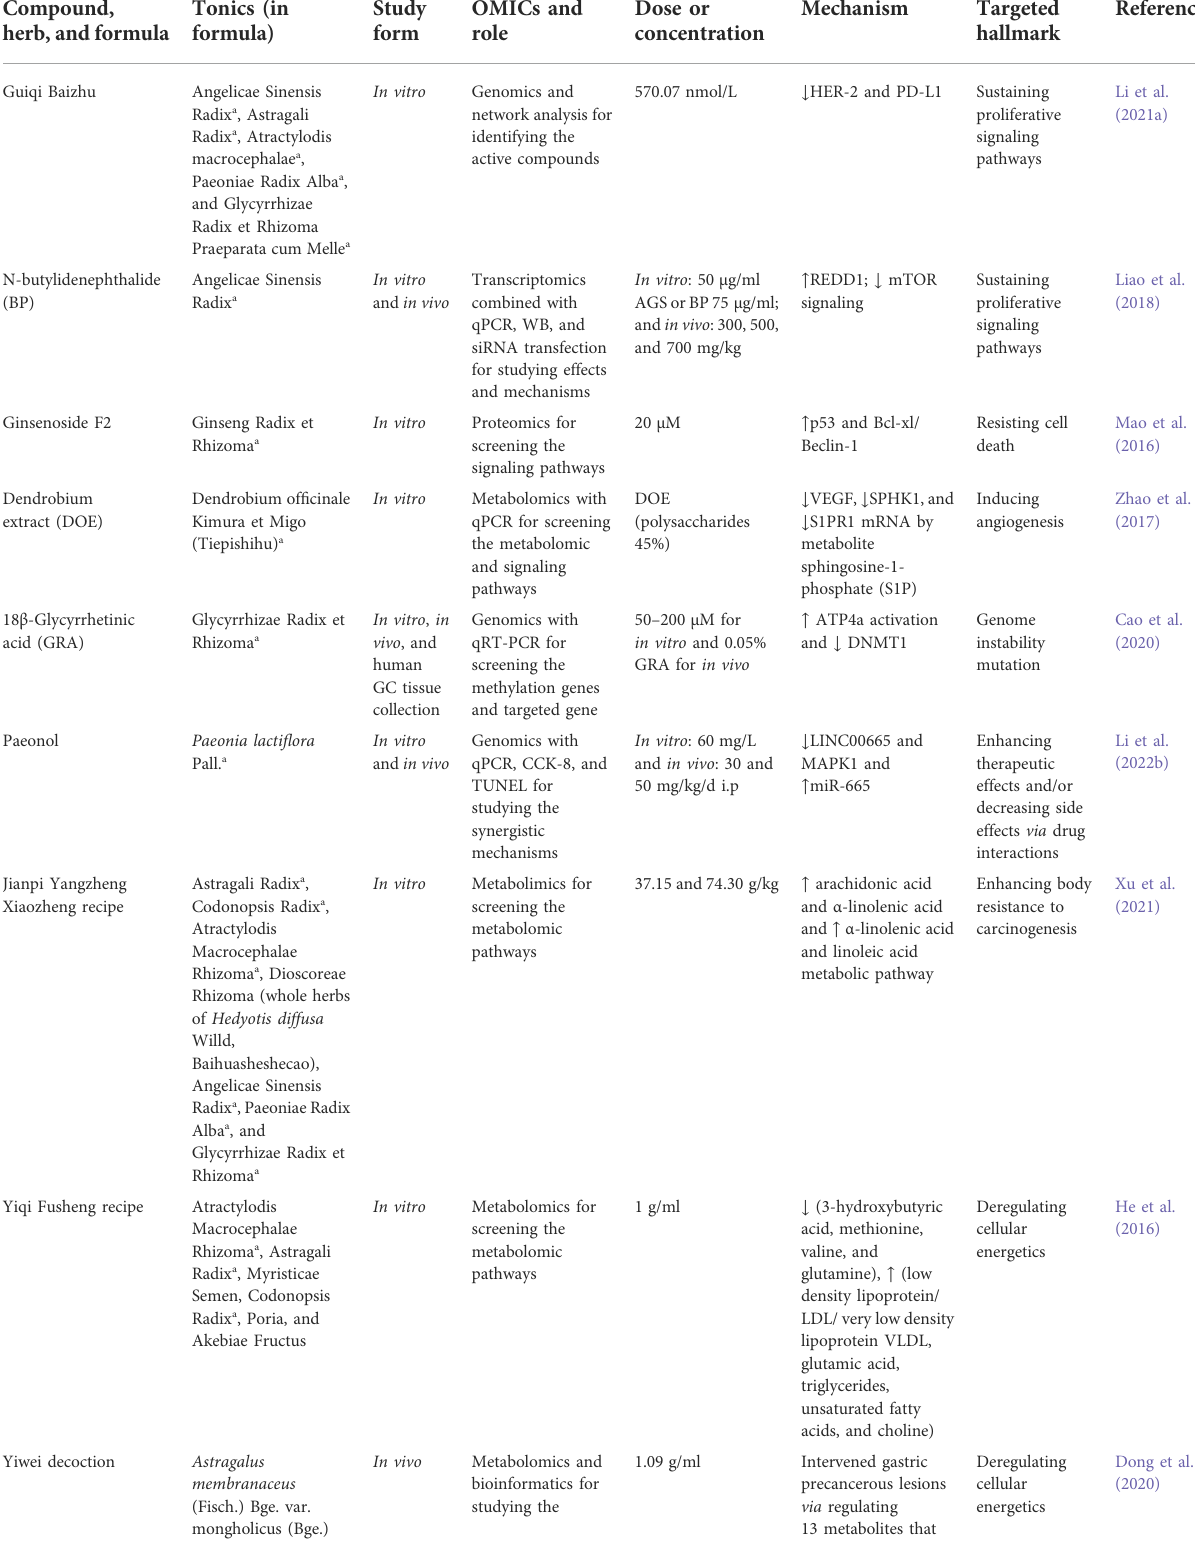
TABLE 1 Applications of OMICs on tonics as adjuvants in gastric cancer. Compound, Tonics (in herb, and formula